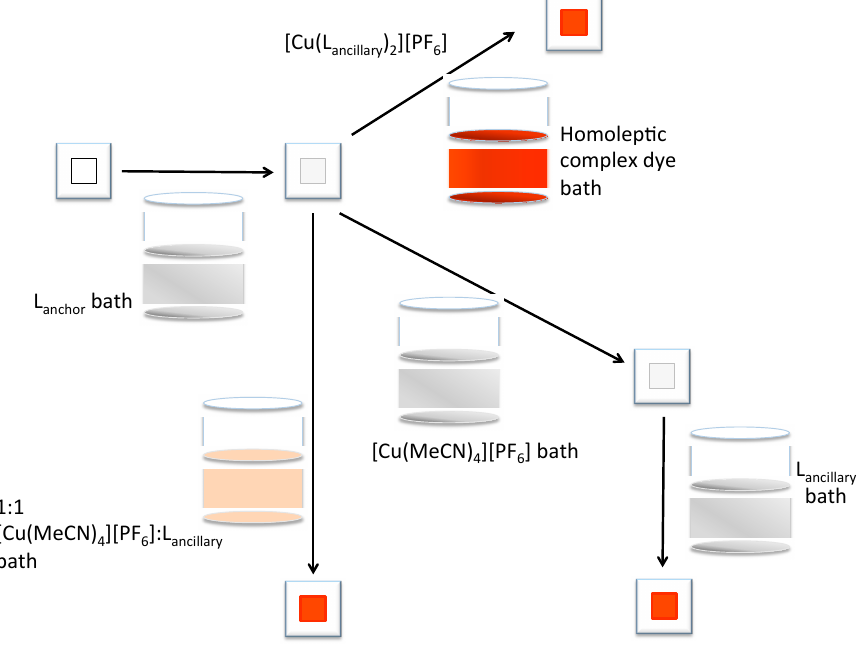
Figure 4. Three approaches to heteroleptic copper(I) dye assembly using the “surfaces-as-ligands, surfaces as complexes” (SALSAC) strategy. See text for discussion.